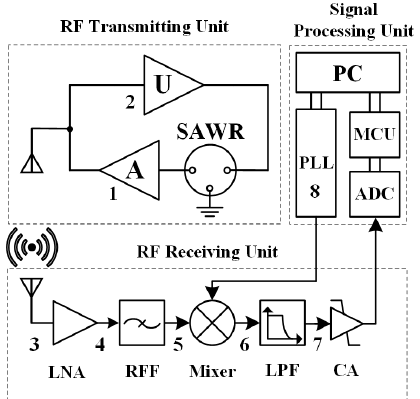
Figure 4. The hardware components diagram of the gyroscopic effect testing system.